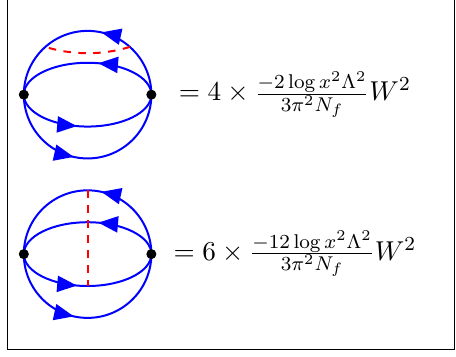
Table 5 . (bQED + ) quartic adjoint-2 renormalization. (contribution from graphs with HS